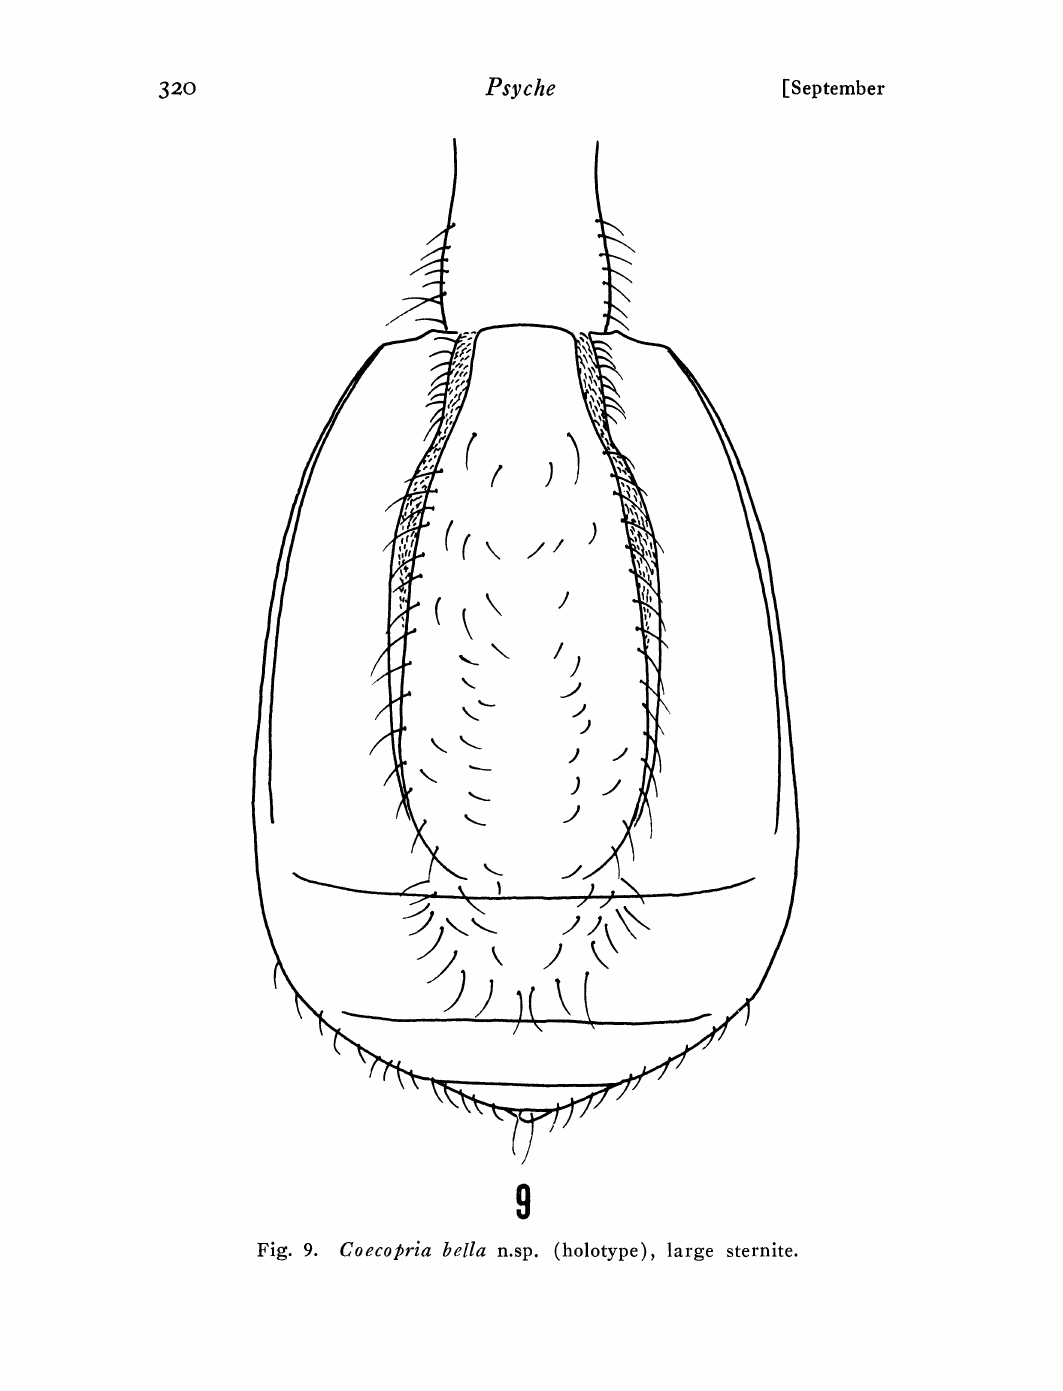
Fig. 9. Coecoria bella n.sp. (holotype), large